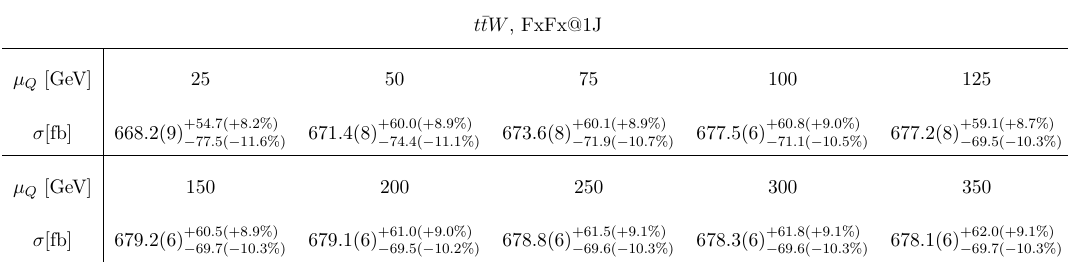
Table 2 . Cross section comparisons for t ¯ tW using different merging scale choices. The error in parenthesis is the absolute MC-error on the last digit of the central value. The scale uncertainties are shown in the form of ±{ absolute } ( ±{ relative in % } )